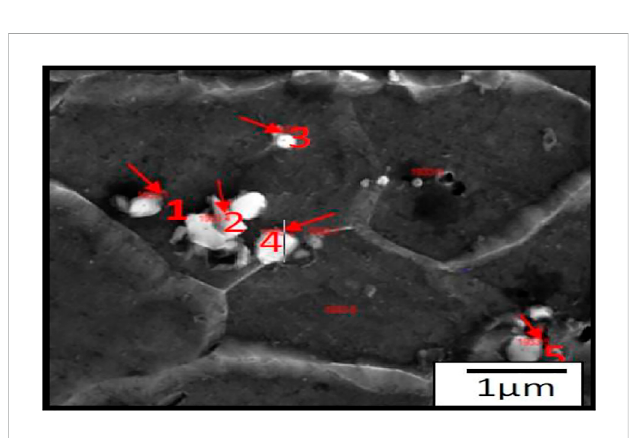
FIGURE 6 SEM micrographs showing the presence of carbide particles inside the